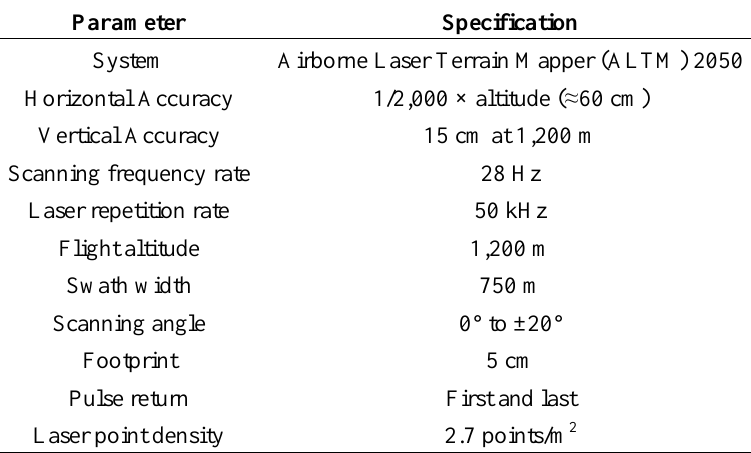
Table 1. The LiDAR dataset